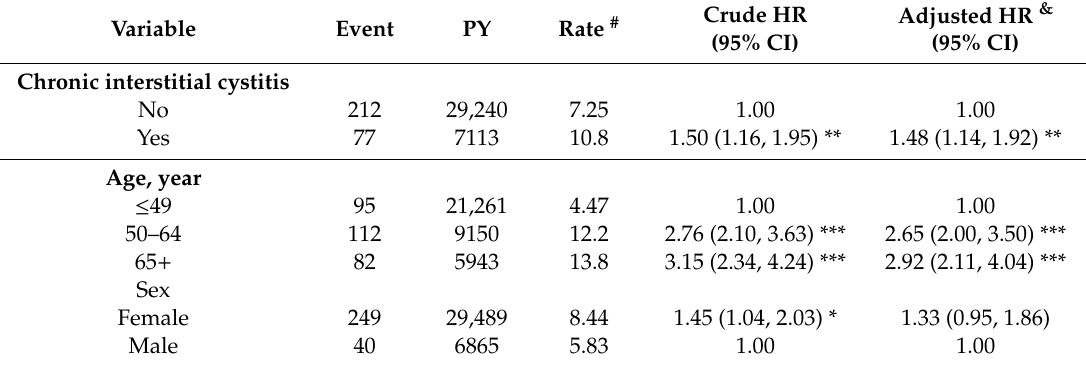
Table 2. The incidence and risk factors for herpes